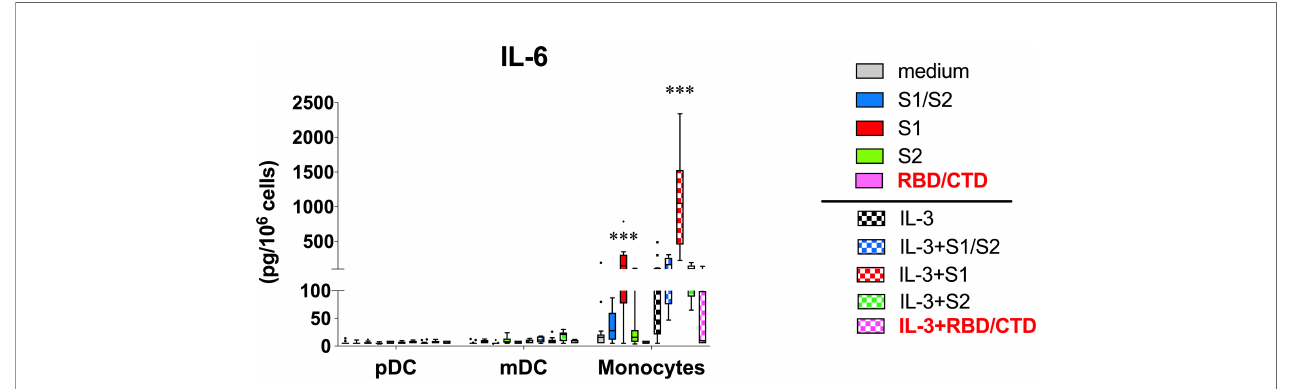
FIGURE 3 | Capacity for S1 to activate monocytes for IL-6 secretion is lost using only the CTD/RBD region known to bind ACE2. Additional experiments (n = 5) were conducted like those described in Figure 1 to test whether the S1-CTD/RBD region, which lacks the NTD, is capable of activating monocytes and DC. These experiments included using the full length S1 as a positive control. Since IL-6 measurements were made using ELISA, several supernatants from the multiplex analysis ( Figure 1 ) were included for added validation. Box-Whisker plots (Tukey ’ s method) represent results from different donor cell preparations (n = 5-14). Responses to spike protein components were tested for signi fi cance by comparing to medium/IL-3 controls. ***P < 0.00001.